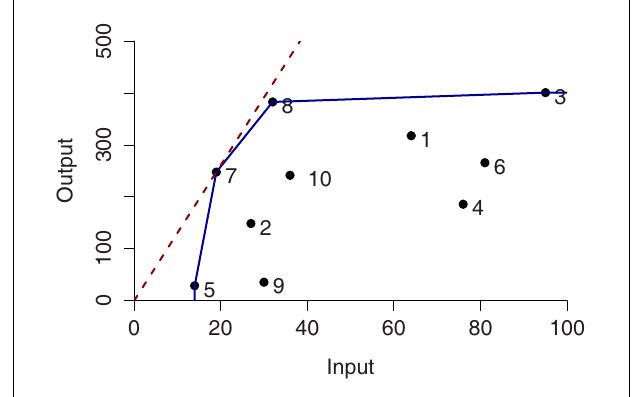
FIGURE 1 | Constant- and variable-returns-to-scale projection in the single input single output case for ten entities. The efficient frontiers are colored in red and blue corresponding to the constant-returns-to-scale (CRS) and variable-returns-to-scale (VRS),